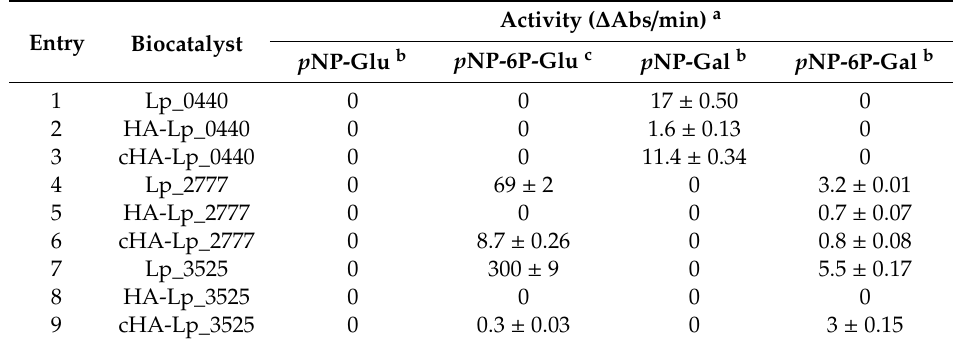
Table 2. Hydrolysis of p -nitrophenyl-glycopyranosides catalyzed by glycosidases from L. plantarum at 40 ◦ C a